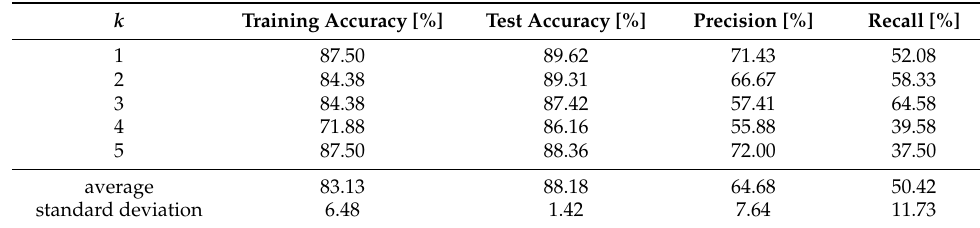
Table 4. Results of deep learning using multiple operating